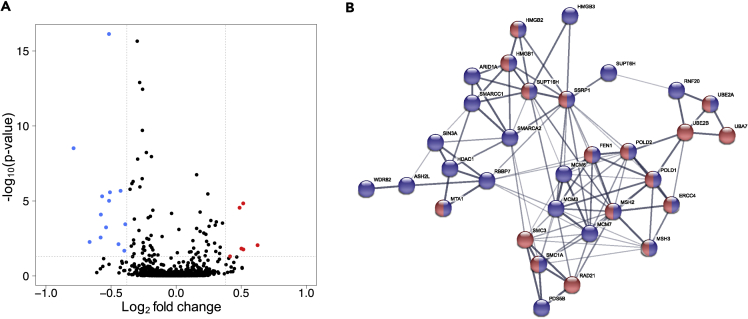
Group Comparison of Proteins in HRD versus Non-HRD Tumors Analyzed by SWATH-MS(A) Relative abundance of up- (red) and down- (blue) regulated proteins in the HRD compared with the non-HRD tumors. The log2-fold change cutoff was 1.3 and the significance cutoff was p < 0.05.(B) Functional enrichment analysis using STRING. Blue nodes: Chromosome organization proteins. Red nodes: DNA repair proteins. Blue and red nodes: Proteins with roles in chromosome organization and DNA repair.